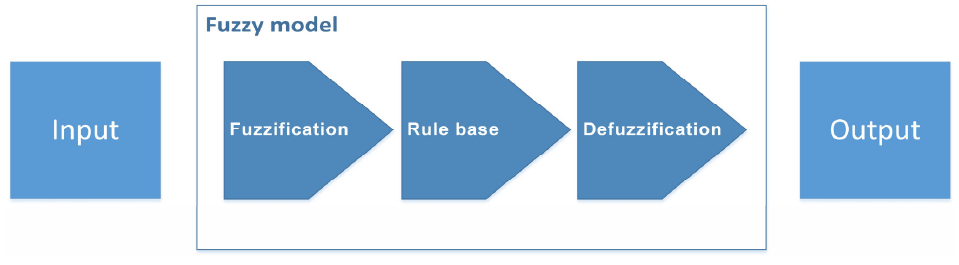
Figure 3. A typical fuzzy inference system’s schema.